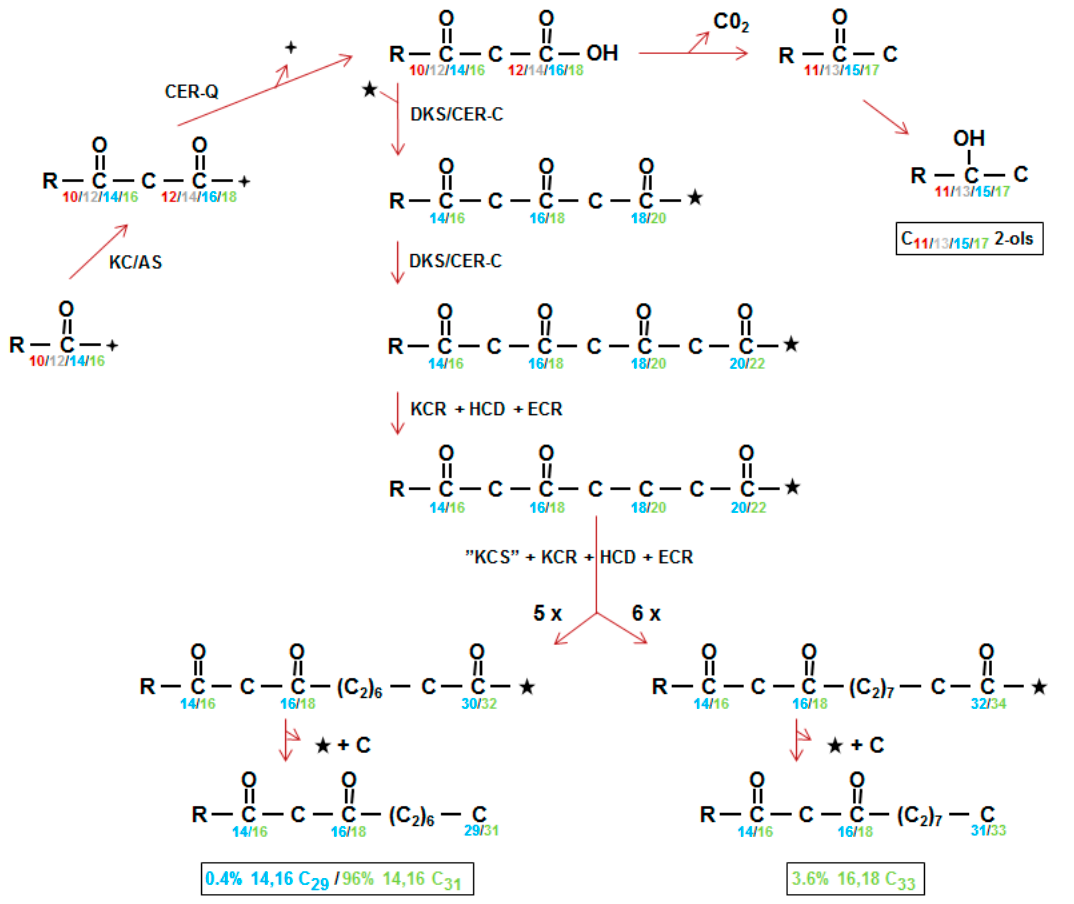
Figure 4. The polyketide pathway synthesizing β -diketones and alkan-2-ols. (Left, middle) KC/AS, either KCS, one of the β -ketoacyl-CoA synthases constructing carbon chains of the ubiquitous wax aliphatics in the endoplasmic reticulum or KAS, the β -ketoacyl-ACP synthase participating in fatty acid synthesis in plastids. CER-Q, a lipase/carboxyl transferase/thioesterase which is envisaged to hydrolyze the 3-oxo substrate (top, center) from ACP, CoA or lipid ( ). The 3-oxo substrate is then decarboxylated to form methylketones that are converted to alkan-2-ols (top right). Neither methylketones nor free alkan-2-ols occur in the wax, instead the latter are found as the alcohol moiety of esters (not shown). DKS/CER-C is the diketone synthase carrying out two extensions in barley giving a tetraketide intermediate (middle) presumably after activation of the 3-oxo substrate by CoA ( ). KCR, β -ketoacyl-CoA reductase; HCD; hydroxyacyl-CoA dehydratase, ECR; enoyl-CoA reductase; “KCS”, condensing enzyme carrying out 5 or 6 extensions (5X, 6X) of the DKS synthesized tetraketides; C, carbon released by unknown mechanism. Numbering in direction of synthesis, except in boxes which give the IUPAC name requiring numbering in opposite direction of synthesis, of the three in vivo synthesized β -diketones [38]. Weight % of the β -diketones is given in Table 4. The homologs of CER-Q and DKS in wheat are named Diketone Metabolism-Hydrolase and Diketone Metabolism-PKS, DMH and DMP, respectively [27].